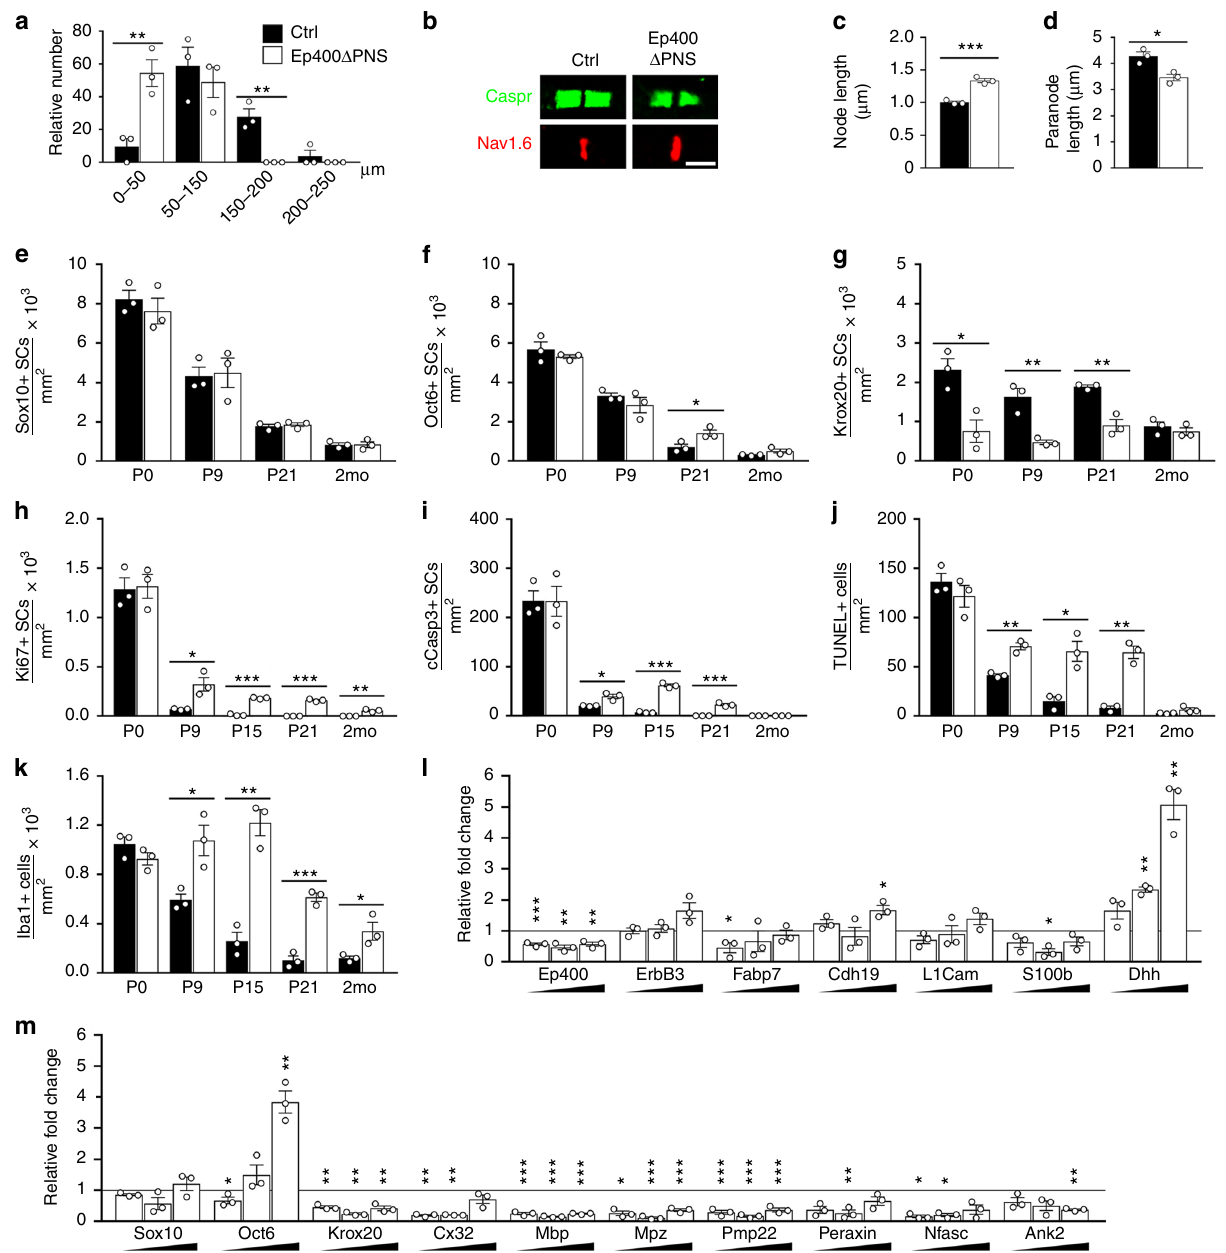
Fig. 2 Sciatic nerve features in Ep400 Δ PNS mice. a Relative distribution of internodal length in stained teased fi bers from sciatic nerves of control (black bars) and Ep400 Δ PNS (white bars) mice at P21 ( n = 3, approximately 50 internodes measured per nerve). b Representative confocal images of paranode (green, for Caspr) and node (red, for Nav1.6) stainings in teased fi bers obtained from sciatic nerves of control and Ep400 Δ PNS mice at P21 by immunohistochemistry. Scale bar: 5 µ m. c , d Length determination of node and paranode in sciatic nerves of control and Ep400 Δ PNS mice at P21 from confocal images of teased fi bers after immunohistochemistry ( n = 3; mean values± SEM). e – k Comparison of the total number of Sox10-positive Schwann cells (SCs) ( e ), Oct6-positive pro-myelinating SCs ( f ), Krox20-positive myelinating SCs ( g ), Ki67-positive proliferating SCs ( h ), cleaved Caspase 3-positive apoptotic SCs ( i ), total TUNEL-labeled cells ( j ), and Iba1-positive macrophages ( k ) in sciatic nerve sections of control and Ep400 Δ PNS mice at P0, P9, P15, P21, and at 2 months (2mo) of age ( n = 3; mean values ± SEM). l , m Determination of transcript levels for Ep400 , ErbB3 , Fabp7 , Cdh19 , L1Cam , S100b , Dhh , increasing age (P9, P21, and 2mo from left to right, indicated by triangle below the bars) by quantitative reverse transcriptase PCR as compared to transcript levels in age-matched control tissue, which were arbitrarily set to 1 (marked by line) ( n = 3; mean values ± SEM). Statistical signi fi cance was determined for a particular parameter or gene at a particular age between control and Ep400 Δ PNS mice by two-tailed Student ’ s t test (* P ≤ 0.05; ** P ≤ 0.01; *** P ≤ 0.001). Exact values are listed in Supplementary Tables 3 – 6 and source data are provided as a Source Data fi